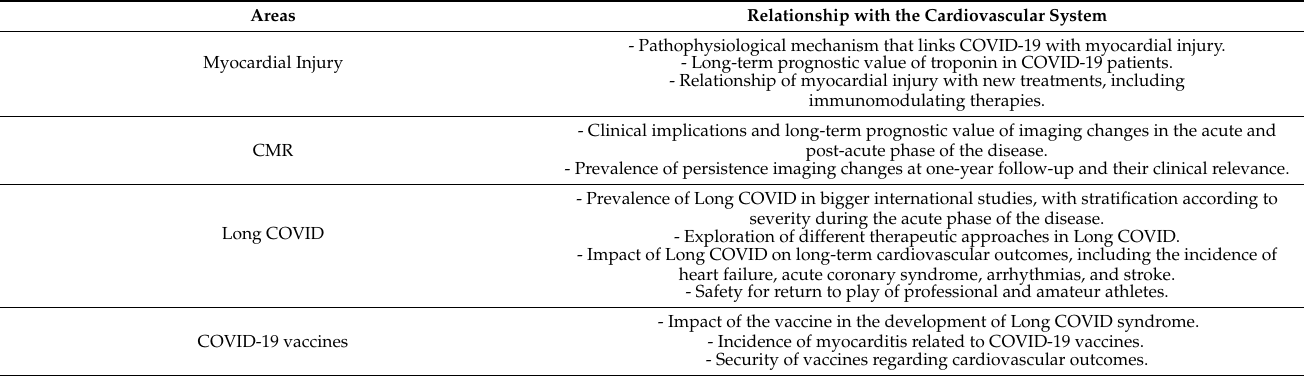
Table 2. Areas of interest in the investigation of COVID-19 and its relationship with the cardiovascular system.